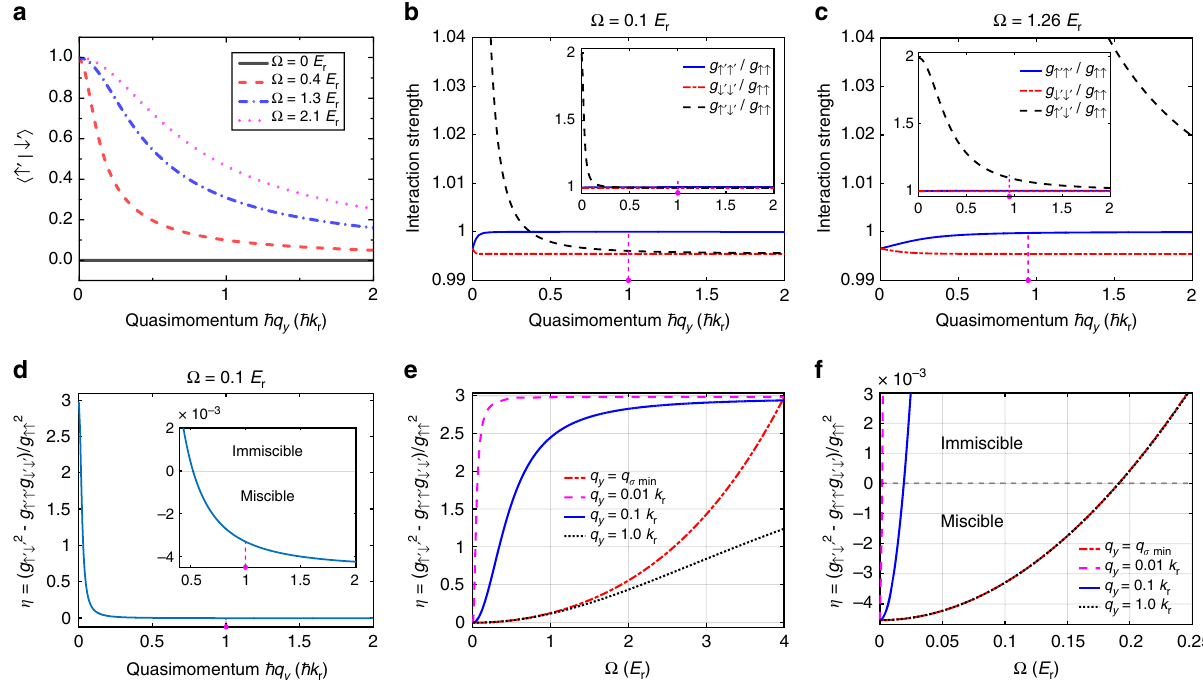
Fig. 7 Calculated nonorthogonality, effective interaction parameters, and immiscibility for two dressed spin states. In ( a – f ), the calculations consider " ′ j i and # ′ j i located respectively at ħ q y and − ħ q y . a When Ω = 0, the nonorthogonality is zero because the two bare spin components are orthogonal. When Ω ≠ 0, either increasing Ω or decreasing q 〈 ↑ ′ | ↓ ′ 〉 , giving rise to stronger interference and more signi fi cant density modulations in the y would increase spatially overlapped region of the two dressed spin components. b , c Effective interspecies ( g ↑ ′ ↓ ′ ) and intraspecies ( g ↑ ′ ↑ ′ , g ↓ ′ ↓ ′ ) interaction parameters versus quasimomentum at Ω = 0.1 E r and 1.26 E r , respectively. When Ω increases or q y decreases, g ↑ ′ ↓ ′ increases while g ↑ ′ ↑ ′ and g ↓ ′ ↓ ′ almost remain at the bare values. As q y → 0 at any fi nite Ω , g ↑ ′ ↓ ′ → 2 g ↑ ′ ↑ ′ or 2 g ↓ ′ ↓ ′ , which is the upper bound of g ↑ ′ ↓ ′ (see Methods). The inset of b , c zooms out to show the (cid:1) (cid:3) = g 2 maximum. d shows the immiscibility metric η ¼ g 2 in Eq. (13) (see Methods) versus ħ q y corresponding to b . η < 0 means miscible, and (cid:2) g " ′ " ′ g # ′ # ′ " ′ # ′ "" ħ q η > 0 means immiscible. Over the range of plotted ħ q y , d can be miscible or immiscible depending on y . The inset of d zooms in to focus on the sign change of η . The vertical dotted line in ( b – d ) indicates ħ q σ min corresponding to the Ω in each case. The calculations are performed in the two-state picture described by Eq. (1) with δ R = 0. e , f Immiscibility metric η versus Ω for various q y . In e , as Ω becomes larger or q y becomes smaller, the two dressed spin components can become more immiscible until η reaches the maximum value set by the upper bound of g ↑ ′ ↓ ′ (see also b , c ). f Zoom-in of e showing the miscible to immiscible transition (indicated by the gray dashed line at η = 0) as a function of Ω for various q y . The red dot-dashed line corresponds to two dressed spin components located respectively at the band minima q σ min , showing the well-known miscible to immiscible transition around 0.2 E r for a stationary SO-coupled BEC. In the dynamical case studied here, BECs can be located away from the band minima and approach q y = 0, becoming immiscible even when Ω < 0.2 E r for small enough q